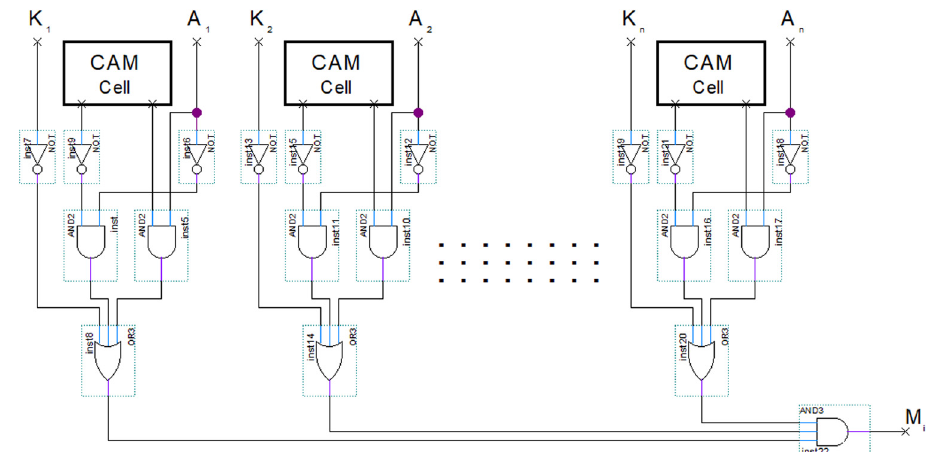
Figure 2: Matching logic for each word ( n - bits ) in